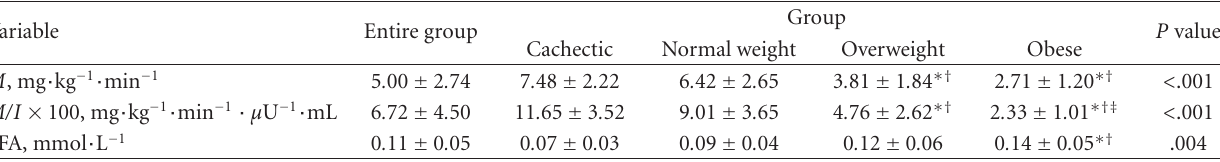
Table 3: Insulin sensitivity determined by euglycemic hyperinsulinemic clamp and insulin-induced serum-free fatty acids in patients with